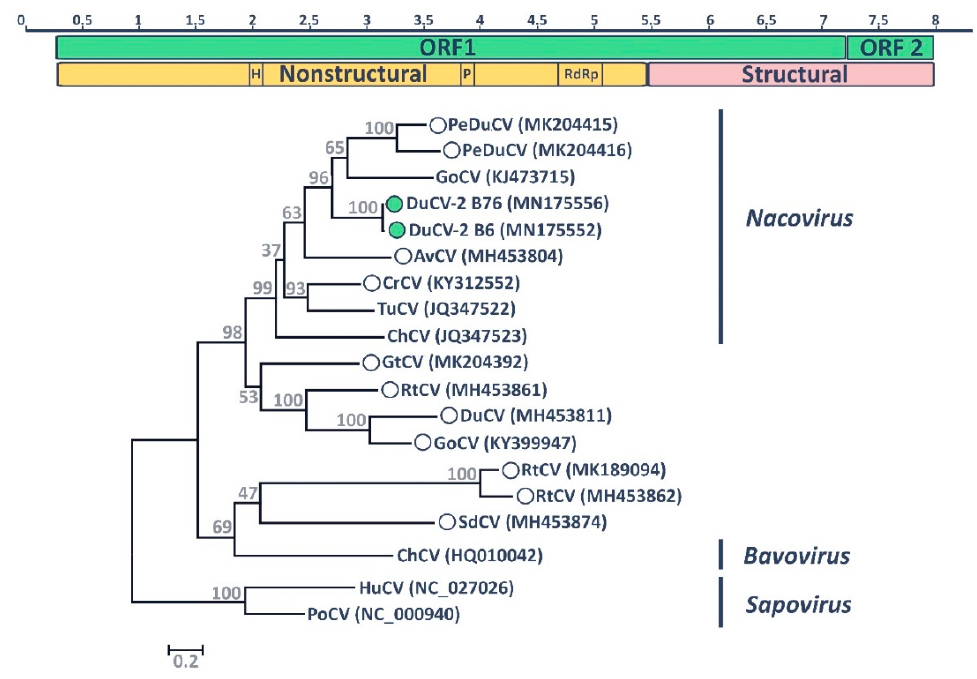
Figure 3. Molecular characteristics of DuCV-2 B6. The genome organization of the novel virus is depicted at the top. The two identified ORFs are illustrated by green rectangles, while nonstructural and structural protein regions are indicated in yellow and pink, respectively. Enzymatic domains typical of caliciviruses are indicated (H: helicase / NTPase; P: 3C-like cysteine protease; RdRp: RNA-dependent RNA polymerase) and the scale bar above indicates genomic position in Kb. The phylogenetic placement of DuCVs-2 B6 and B76 within the genus Nacovirus based on the predicted amino acid sequence of the major capsid protein (VP1) is shown at the bottom. Hosts of viruses used for phylogenetic reconstruction are indicated within the strain designation (PeDu: Pink-eared duck; Du: Duck; Go: Goose; Av: Avocet; Cr: Crane; Tu: Turkey; Ch: Chicken; Gt: Grey teal; Rt: Ruddy turnstone; Sd: Shelduck; Hu: Human; Po: Porcine), while accession numbers of sequences are indicated in parentheses. Viral genera are depicted on the right and the two mammalian caliciviruses of the genus Sapovirus were used as an outgroup. Recently identified viruses that lack o ffi cial taxonomic designation are indicated by circles and the viruses identified in this study are indicated by filled green circles. The tree was built with the maximum likelihood method [47] using MEGA 7 [43] based on the Le Gascuel model [50], identified as the best-fitting model by the model test in MEGA. A discrete Gamma distribution was used to model evolutionary rate di ff erences among sites, branch lengths are proportional to genetic distances as indicated by the scale bar, and the outcome of the bootstrap analysis [48] is shown next to the